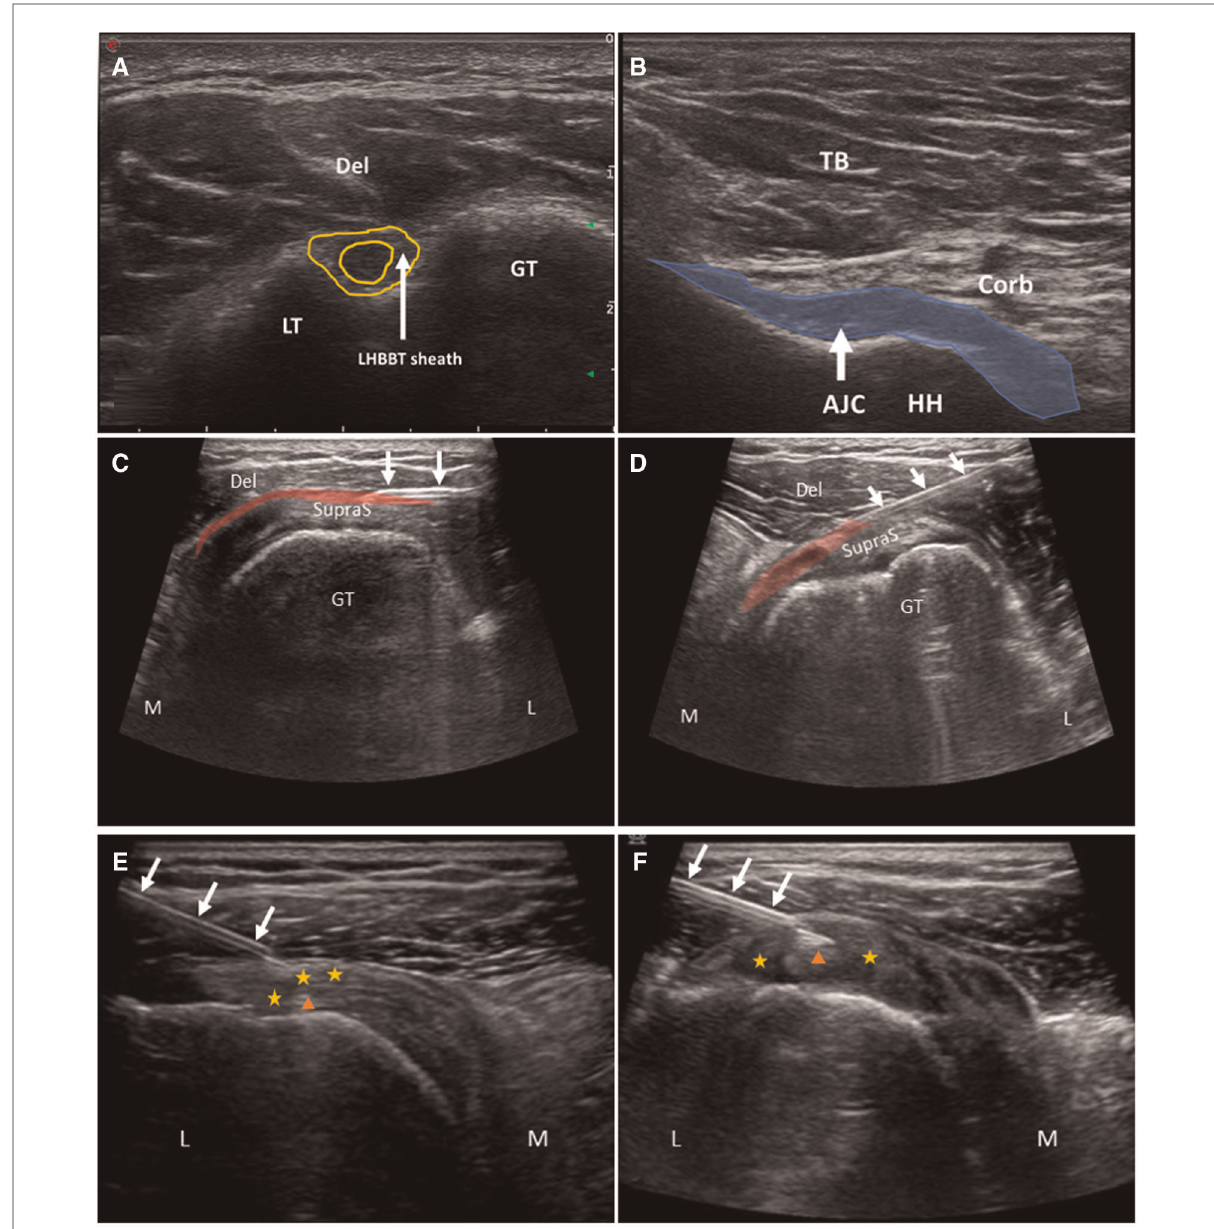
FIGURE 2 A,B are ultrasound images for diagnosis. C (before injection) and D (after injection) are US-guided injection into the subacromial Bursa. E (before injection) and F (after injection) are intrathecal injection into the LHBBT sheath. Del, deltoid muscle; TB, Triceps brachii; Corb, coracobrachialis; AJC, axillary joint capsule; HH, humeral head; GT, greater tubercle of humerus; LT, lesser tubercle of humerus; SupraS, supraspinatus tendon; L, lateral; M, medial; yellow star, rotator interval; orange triangle, the long head of the biceps brachii tendon (LHBBT); highlighted red area, subacromial Bursa. White arrows indicate the injection